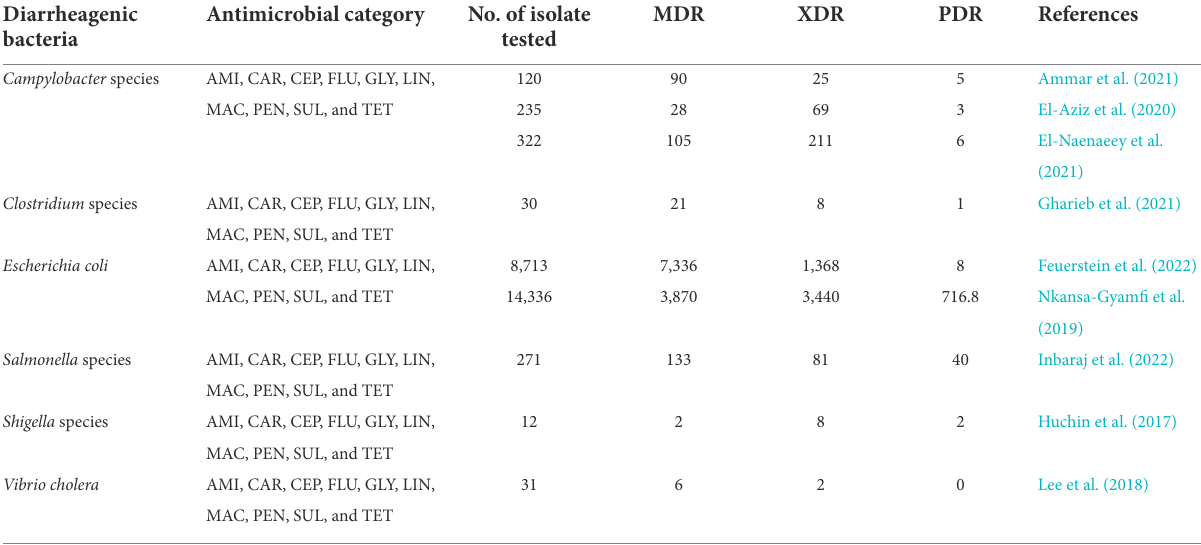
TABLE 2 Diarrheagenic bacteria classification based on their antimicrobial resistance capacity. Diarrheagenic